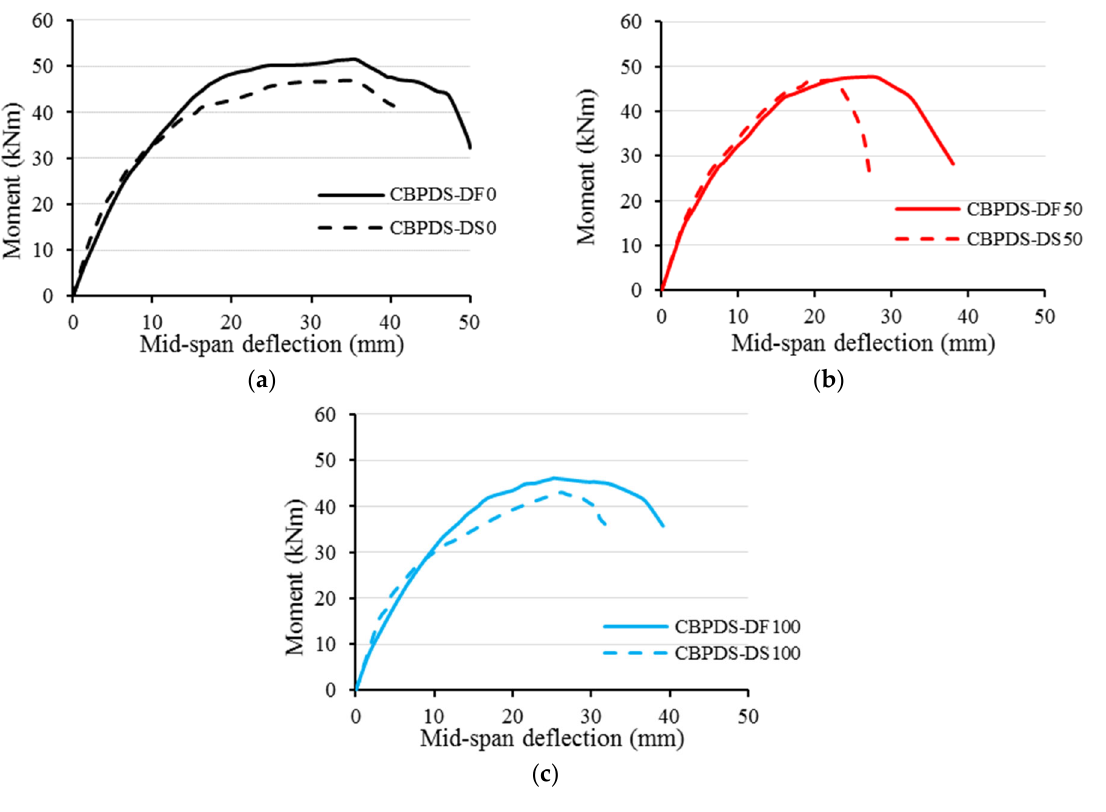
Figure 12. Moment–de fl ection relationships of specimens. ( a ) MC0 ; ( b ) MC50 ; ( c ) MC100 .